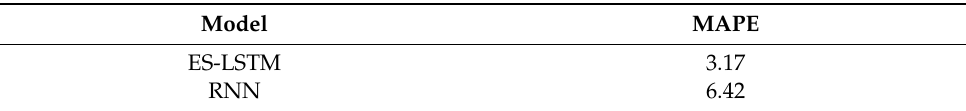
Table 5. Results of MAPE for time series (slide window) step.